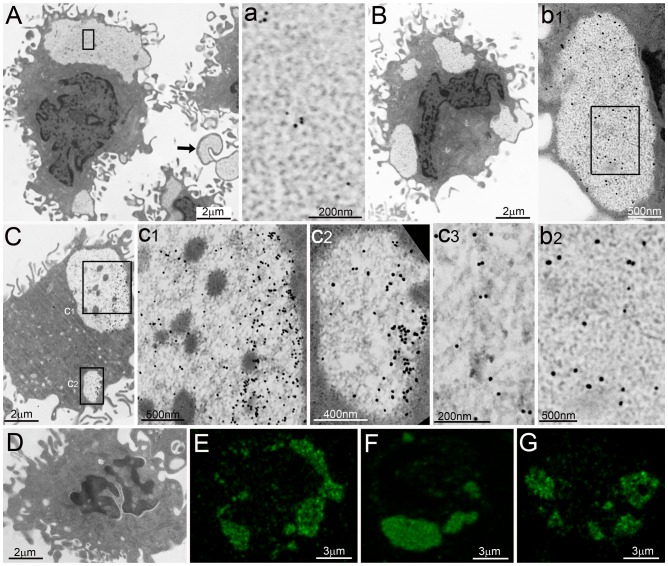
PaCS in human DCs.(A) Several PaCS-filled blebs (arrow) and intracytoplasmic PaCSs; the largest of which is enlarged (a) to show barrel-like particles and sparse 19S proteasome immunoreactivity. (B) Four PaCSs, one enlarged in (b1) and further in (b2) to show particles FK1 reactivity. (C) Two PaCSs, enlarged in (c1) and (c2), showed glycogen immunoreactivity polarized on the right side; note that PaCS particles were not polarized and that glycogen immunogold deposits were frequently unrelated to them. Selective 20S proteasome reactivity of PaCS particles from another section of the same cell is shown in (c3). (c1) Note residual round islets of cytoskeleton-rich cytoplasm inside cytoskeleton-poor PaCS – an uncommon finding. (D) An untreated blood monocyte lacking cytoplasmic PaCSs. Confocal microscopy of three aldehyde–osmium-fixed DCs showed immunofluorescence for proteasome (E), FK1 (F), and chondroitin sulfate (G).